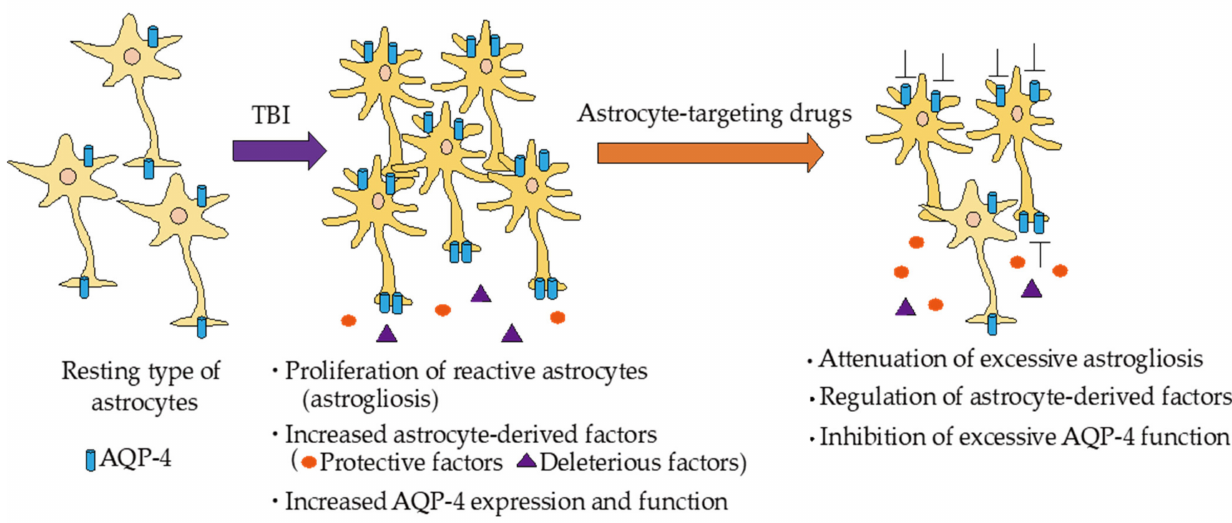
Figure 2. Responses of astrocytes in TBI and expected actions of the astrocyte-targeting drugs. Resting type of astrocyte converts to reactive type in TBI, resulting in induction of astrogliosis. Reactive astrocytes secrete multiple bioactive factors that exert protective and deleterious actions in central nervous tissue in TBI. In addition, expression of aquaporin-4 (AQP-4) is increased in reactive astrocytes, resulting in the promotion of cytotoxic edema formation. Astrocyte-targeting drugs may attenuate excessive astrogliosis, increase protective factors, decrease deleterious factors, and inhibit excessive AQP-4